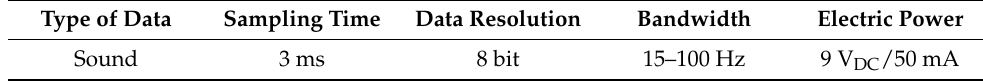
Table 1. Specification of Fetaphon2000 fetal heart monitor. Type of